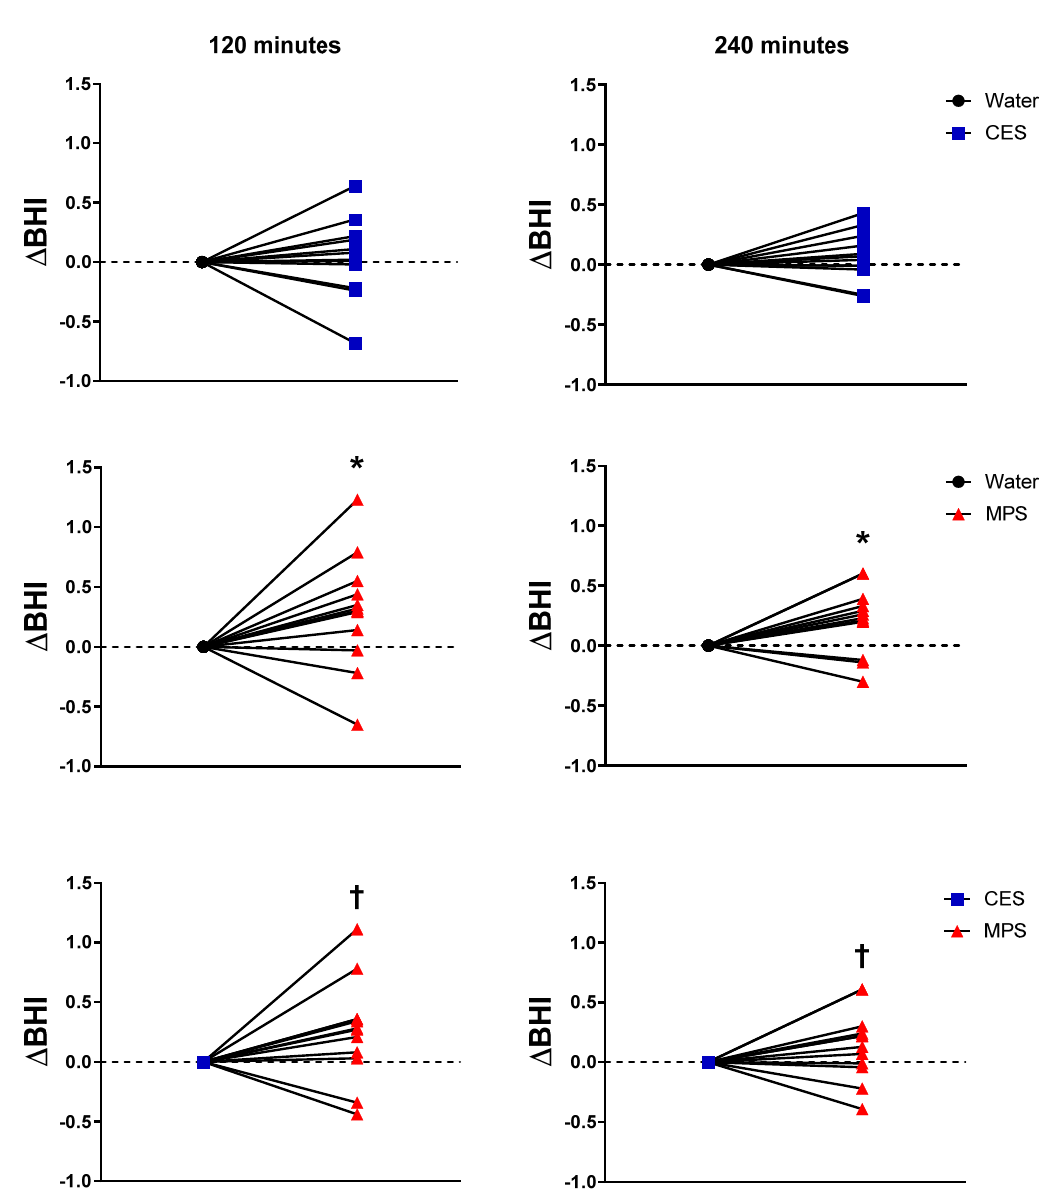
Figure 4. Data for individual subjects showing the difference in BHI for paired beverages. Differences between beverages were assessed by two-way ANOVA. * p < 0.05 MPS compared to water; † p < 0.05 MPS compared to CES.